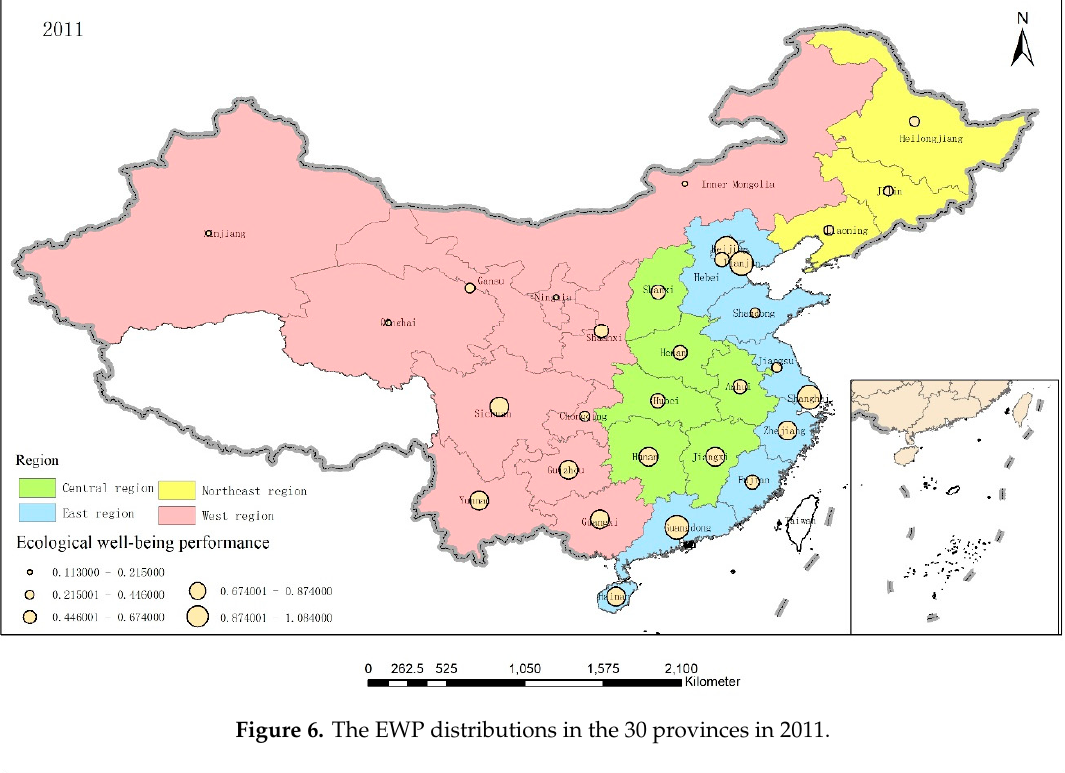
Figure 6. The EWP distributions in the 30 provinces in 2011.